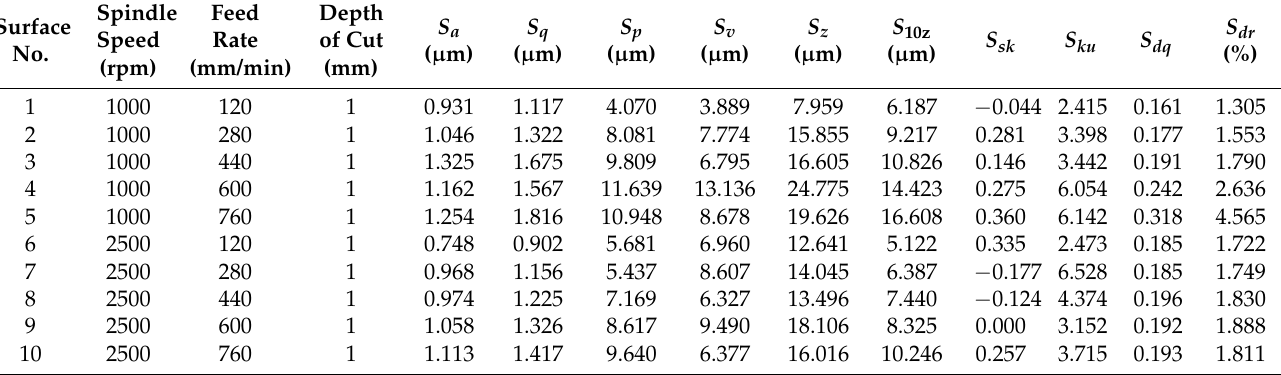
Table 1. 3D surface roughness parameter for each milled